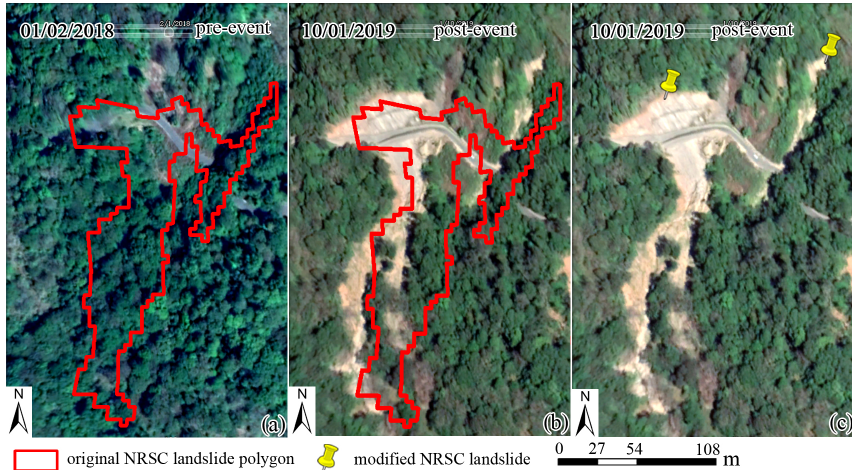
Figure 6. Example of a situation where the original NRSC landslide polygon was subdivided into several landslides, marked by points and digitized on the top of the scarps: (a) pre-landslide image with NRSC landslide polygon on top, (b) post-landslide image with the NRSC polygon on top which shows that there are two landslides instead of a single one, and (c) the mapping of landslide points in the scarps of the two landslides. Basemap data © Google Earth 2019.